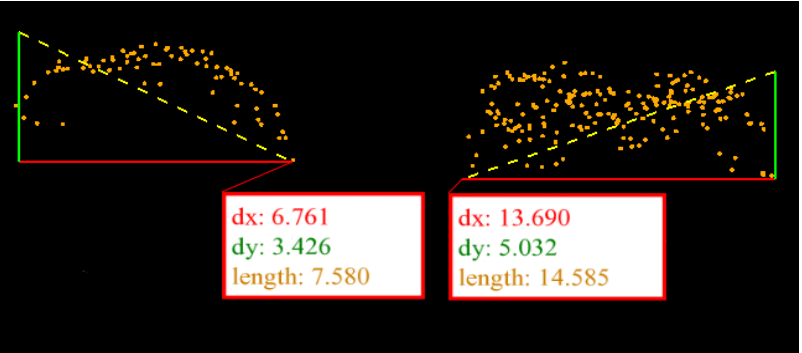
Figure 13. Two missing trees (points in orange) with flat canopies.